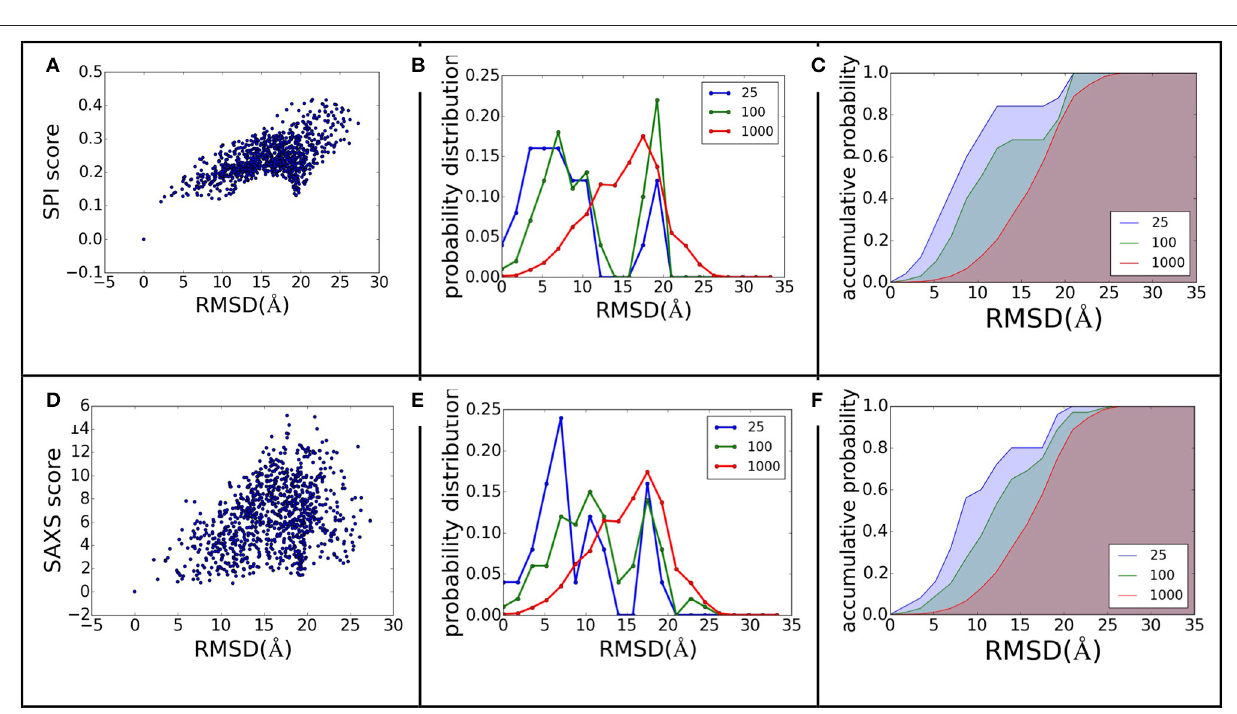
(all) are calculated and compared. Based on the probability distribution and the correlation coefficients between the scoring function and the RMSD, it is clear that both SPI-scores and SAXS-scores are capable of selecting models that have lower RMSD values with respect to the native structure, while the SPI- scores have stronger selecting power. The probability of selecting